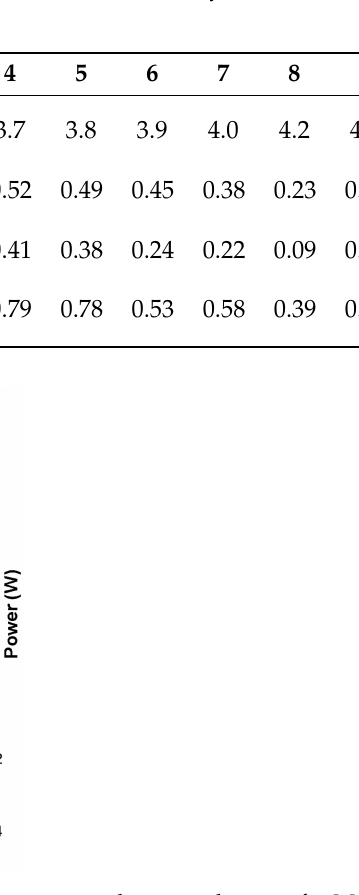
Figure 14. Time series of measured heave motion response and extracted power for M15 model at ω N = 3.8 rad/s (blue solid line = power, red dotted line = heave).